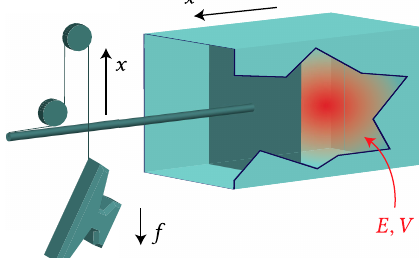
FIG. 2. Macroscopic thermodynamics emerges from our frame- work when singling out a set of states that can be parametrized by continuous parameters to a good approximation and can be reversibly interconverted into one another. We consider the case of a textbook thermodynamic gas confined in a box, with a piston capable of furnishing work. In this setting, we recover the usual second law of thermodynamics, dS ≥ δ Q=T , relating the change in entropy, the dissipated heat, and the